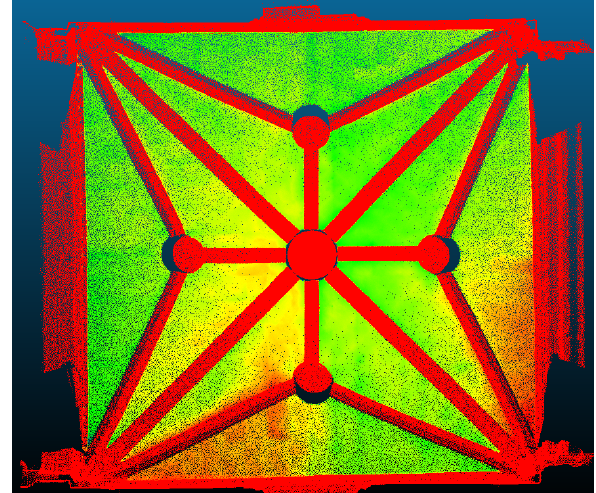
Figure 11. Chromatic scale showing the distances between the point cloud and the NURBS.